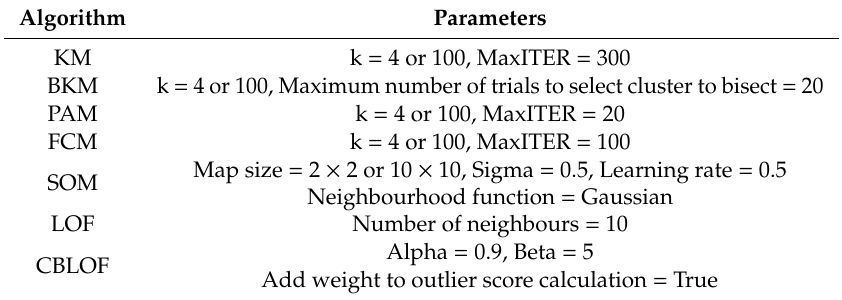
Table 2. Parameter Settings for the Adopted